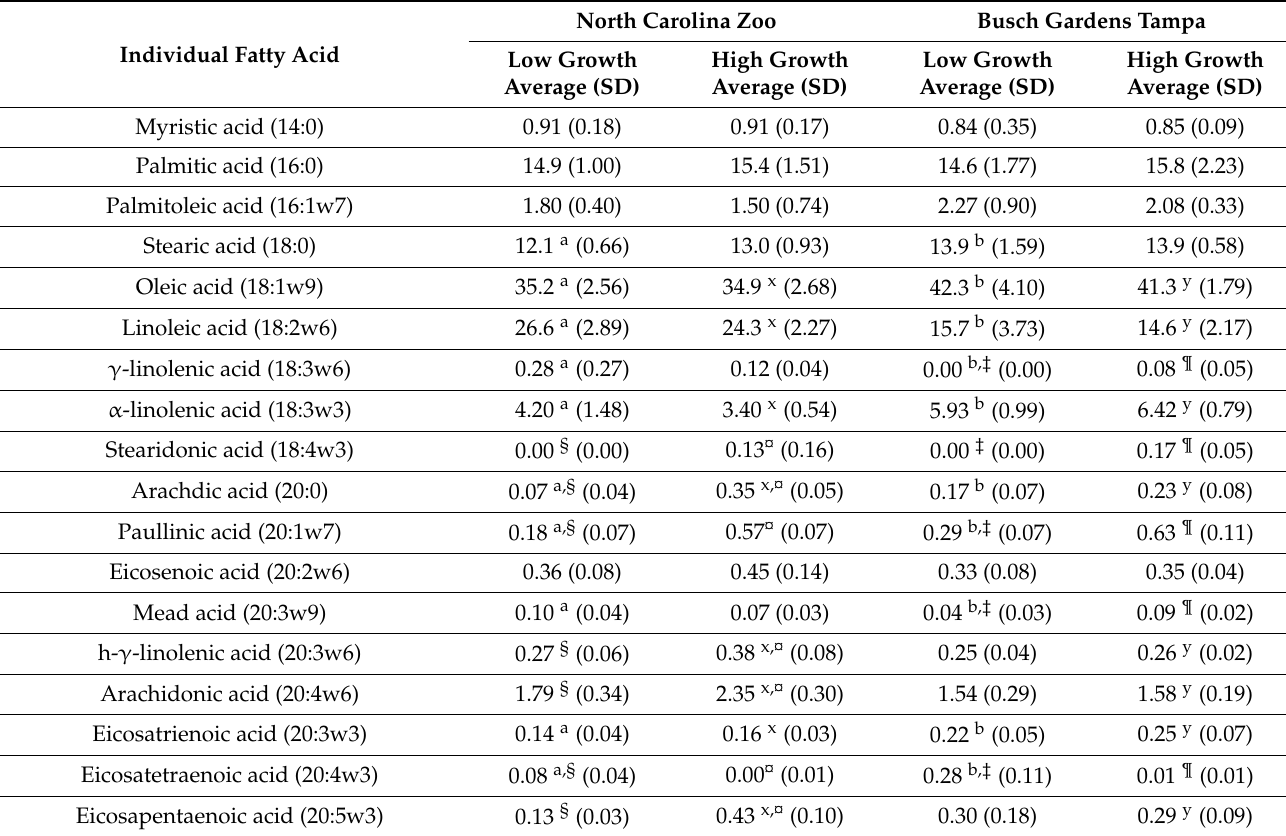
Table 1. Fatty Acid (%) Profile Averages and Standard Deviations (SD) of NC Zoo Dry Blood Spot (DBS) Samples ( n = 6) and Busch Gardens Tampa DBS Samples ( n = 5) from Managed Southern White Rhinoceroses ( Ceratotherium simum simum ) during both Low and High Pasture Growth Periods with a Mann–Whitney U -Test Pairwise Comparisons 1